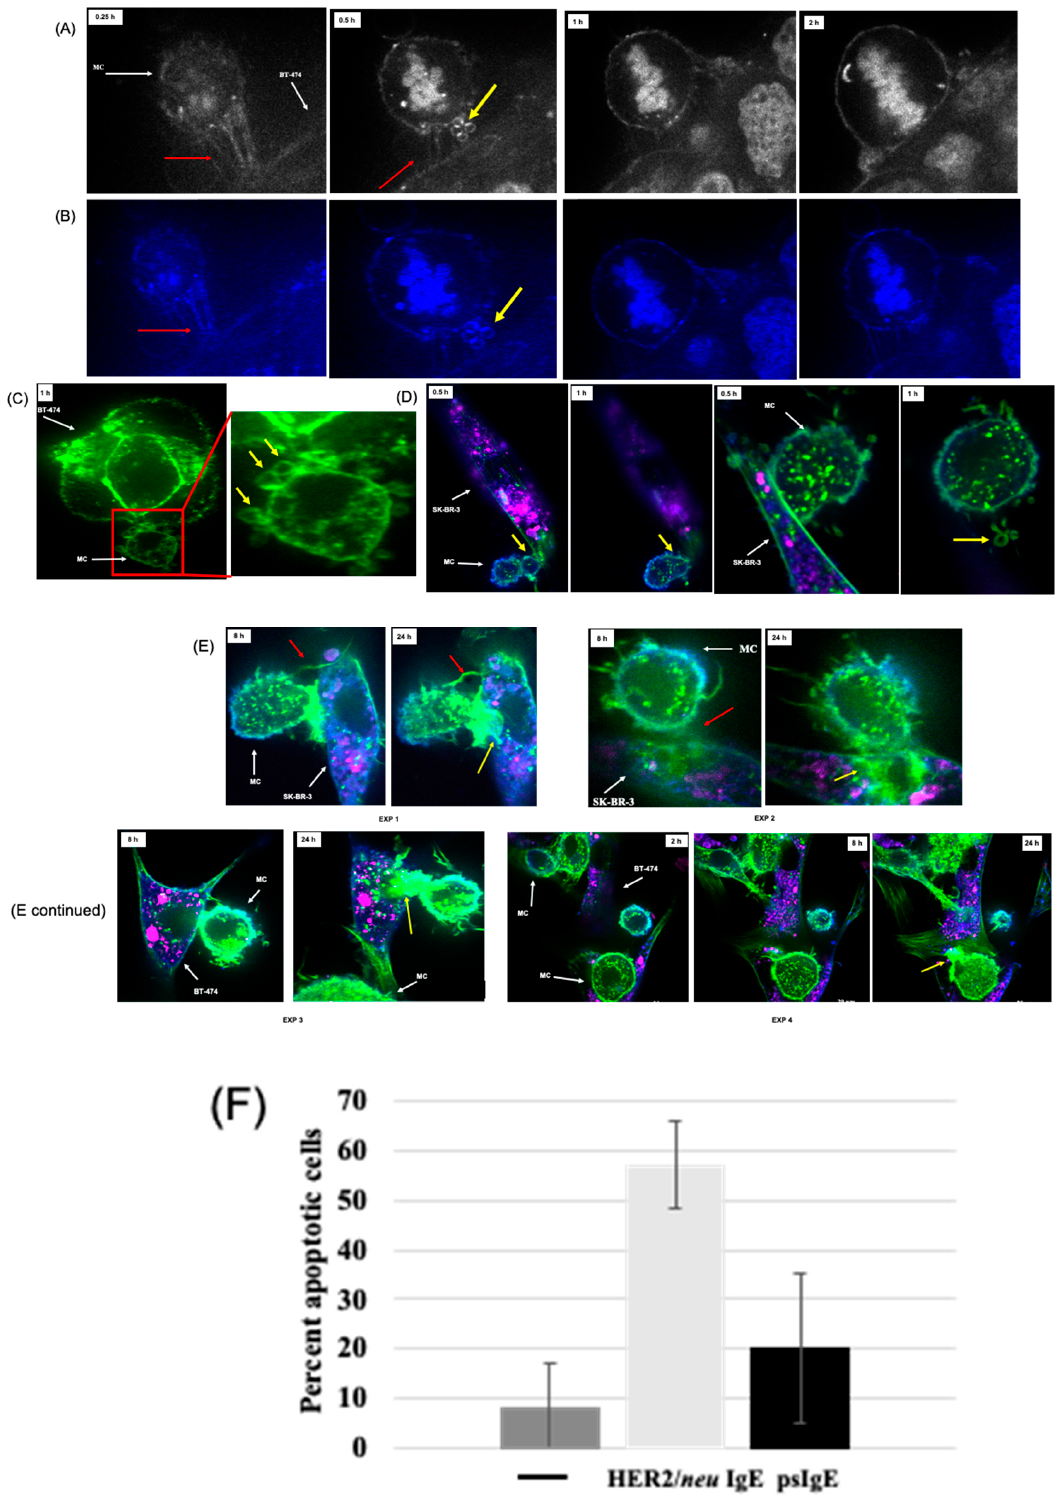
Figure 3. IgE-dependent formation of TnT and membrane blebs between MCs and BC cells. Note. BT-474 or SK-BR3 cells were grown on confocal slides (50–60% confluent). ADMC (1 × 10 5 ) with HER2/ neu IgE were labeled with WGA ( A , B ) or MitoTracker™ Green-FM-labeled ( C – E ), washed and added to the cancer cells (described in the Materials and Methods section) and visualized with black and white and color fluorescent microscopy. ( F ) Quantification of overall apoptosis comparing psIgE and anti-HER2/ neu IgE-sensitized cells at Day 4 from three experiments. Mean ± sd.